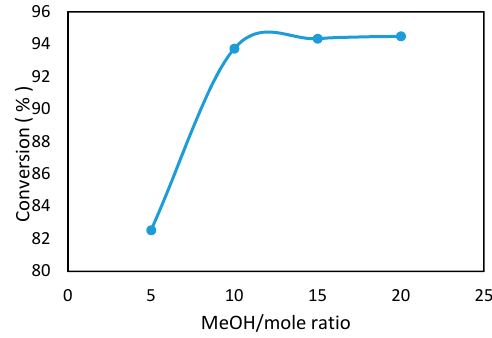
Figure 4. Effect of methanol to free fatty acid (FFA) mole ratio on biodiesel production.